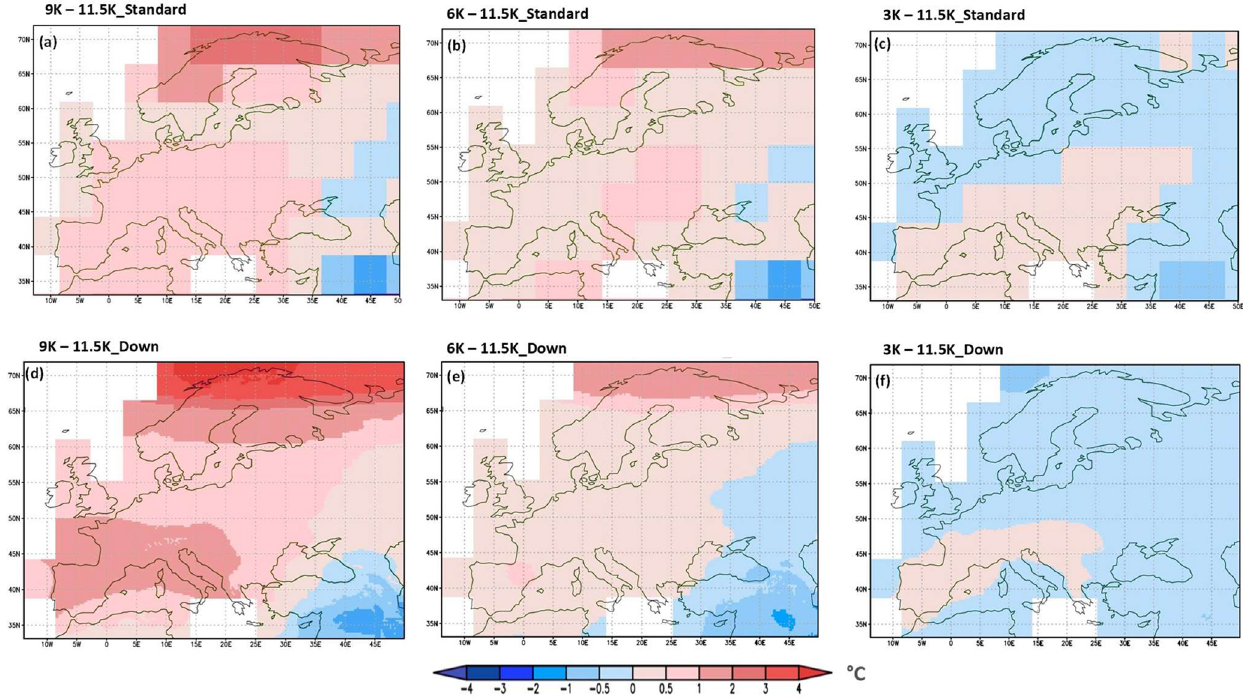
Figure 3. Simulated mean annual temperature anomalies (results minus the pre-industrial mean) showing spatial distribution in Europe for 9kaBP (a, d) , 6kaBP (b, e) and 3kaBP (c, f) for 11.5K_Standard and